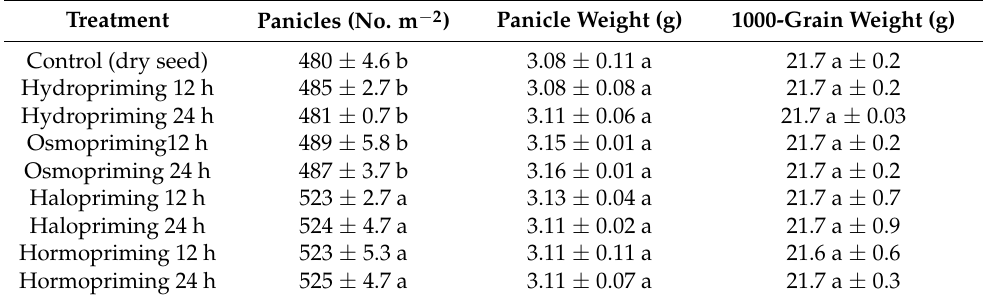
Table 8. Yield attributes (panicle no., panicle weight, and 1000-grain weight) of rice as affected by different seed priming in conventional DSR establishment method during 2018 at Ludhiana,